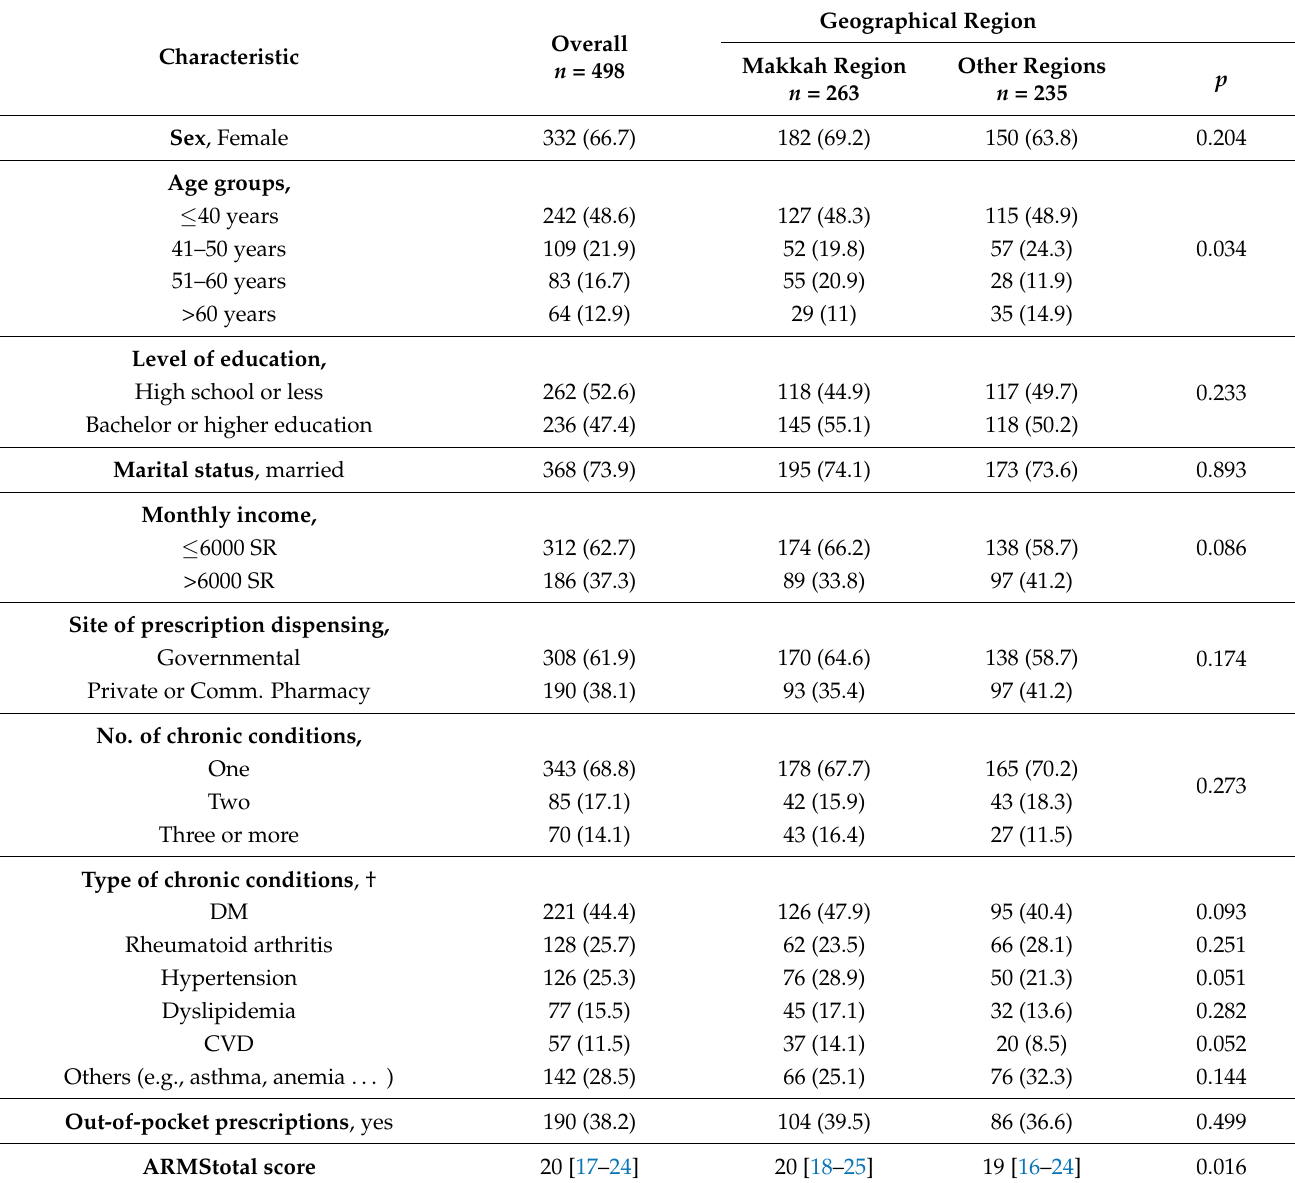
Table 1. Sociodemographic and clinical characteristics of study